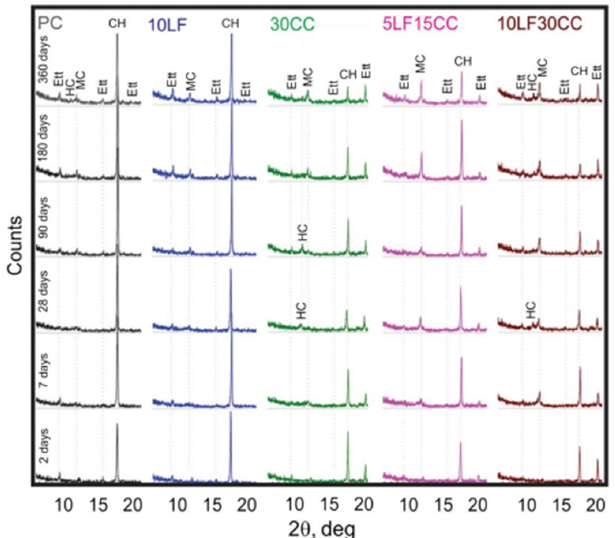
Figure 9. XRD pattern of the hydrated slurry at different ages. Reprinted with permission from Ref. [20]. Copyright: 2017, Edgardo F. Irassar. Published by American Society of Civil Engineers.